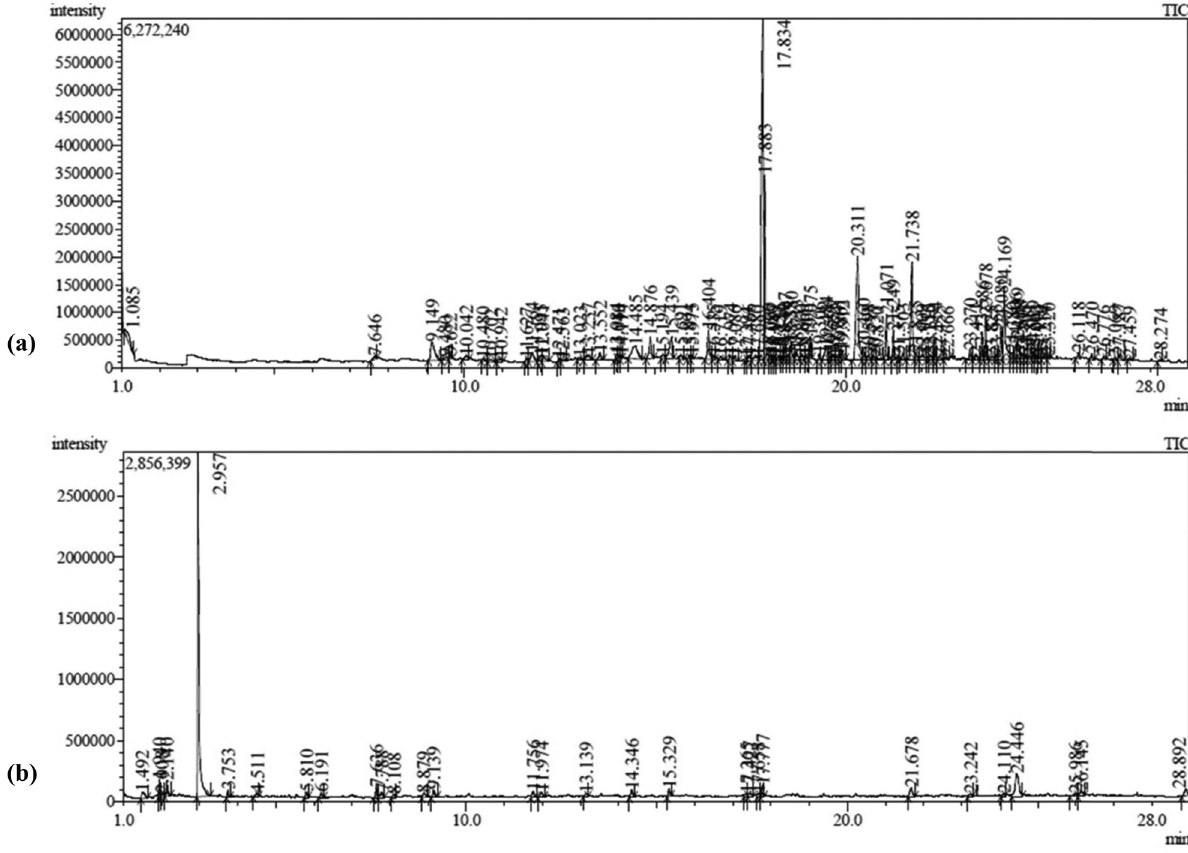
Figure 1: Gas chromatography analysis of P. indica root extracts of methanolic ( a ) and aqueous ( b )